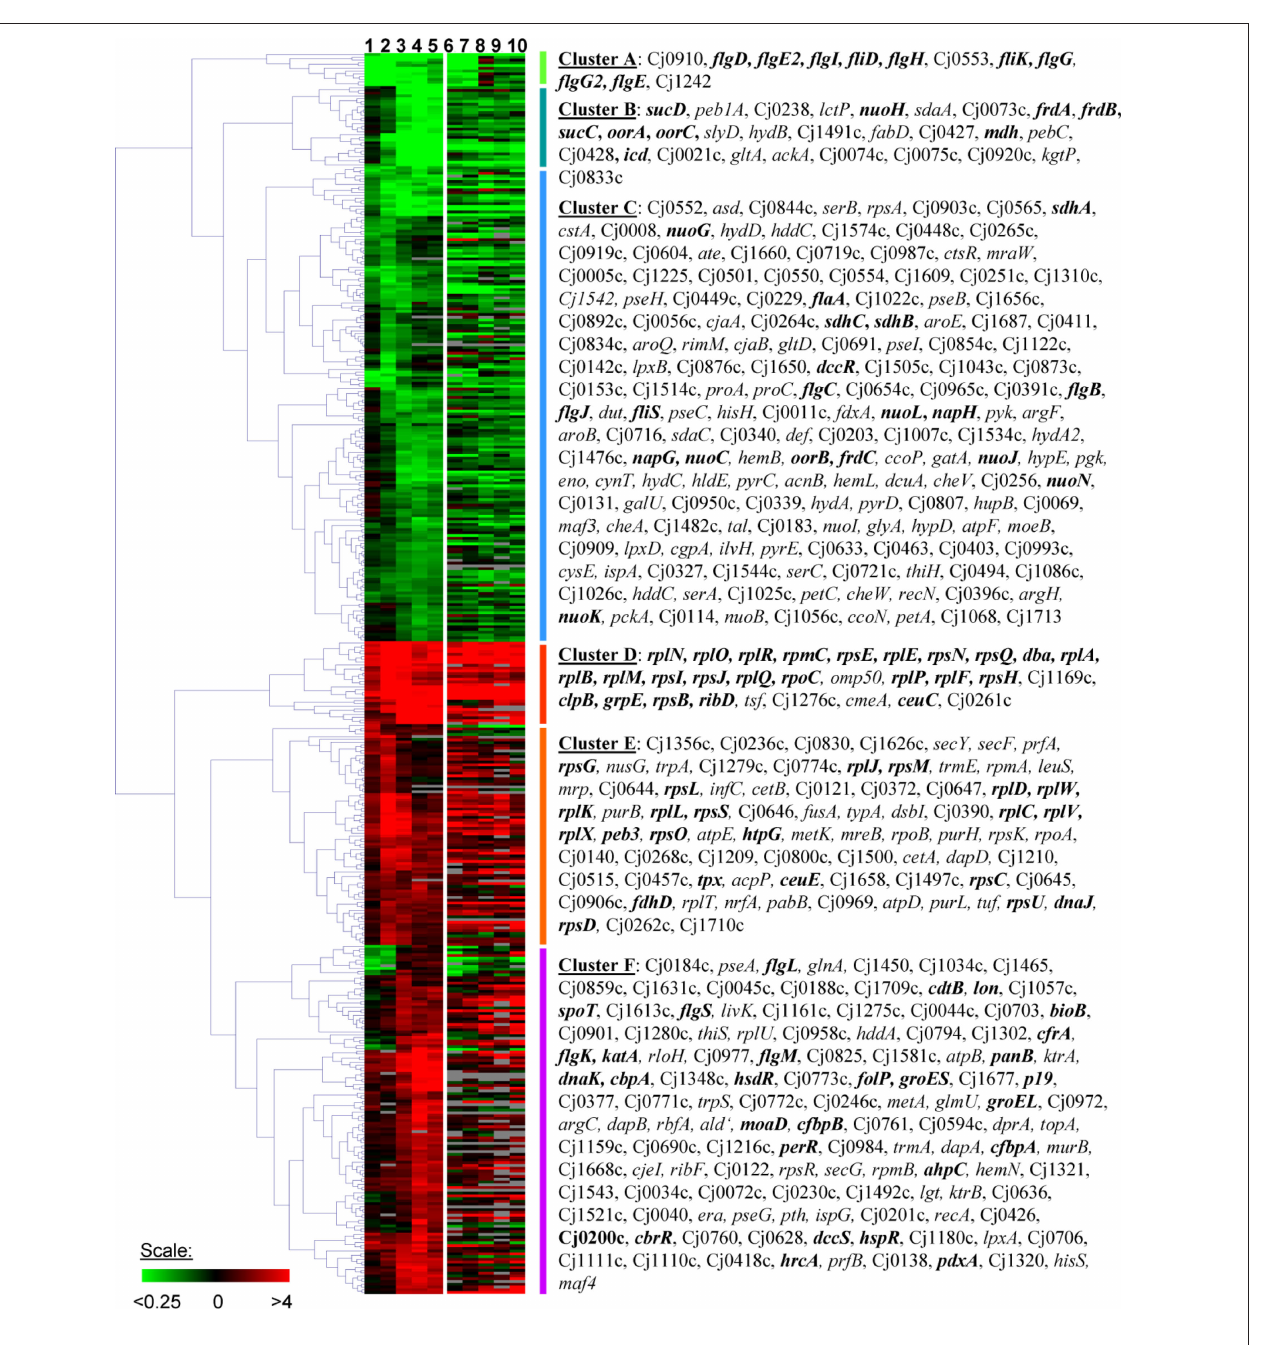
Figure 2 | Hierarchical cluster analysis of genes differentially expressed using the rabbit tissue chamber model. Each row represents one gene. Columns 1–4 represent the expression profile for one biological replicate at fixed time points; column 1, 2 h; 2, 6 h; 3, 28 h; 4, 48 h. Column 5 represents the differential gene expression at 48 h for three biological replicates. Columns 6–10 represent changes